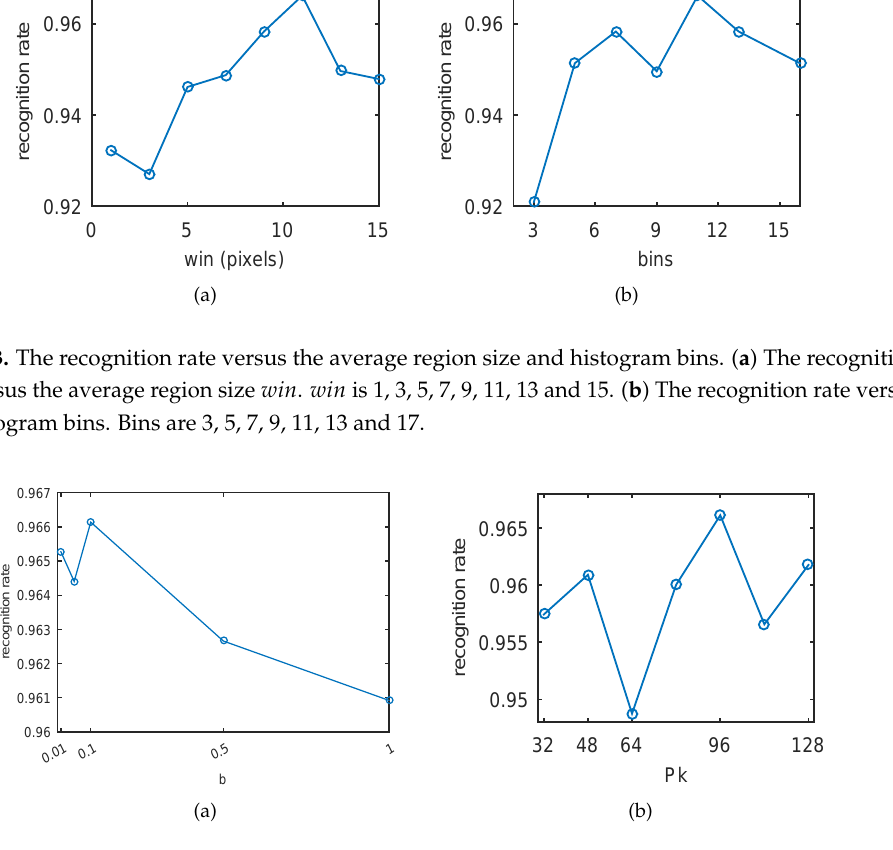
Figure 4. The recognition rate versus b and P k in supervised discriminative dictionary learning (SDDL). ( a ) The recognition rate versus b . b is 0.01, 0.05, 0.1, 0.5 and 1. ( b ) The recognition rate versus P k . P k is 32, 48, 64, 80, 96, 112 and 128. Table 4. The recognition rate versus different (cell, block)s.